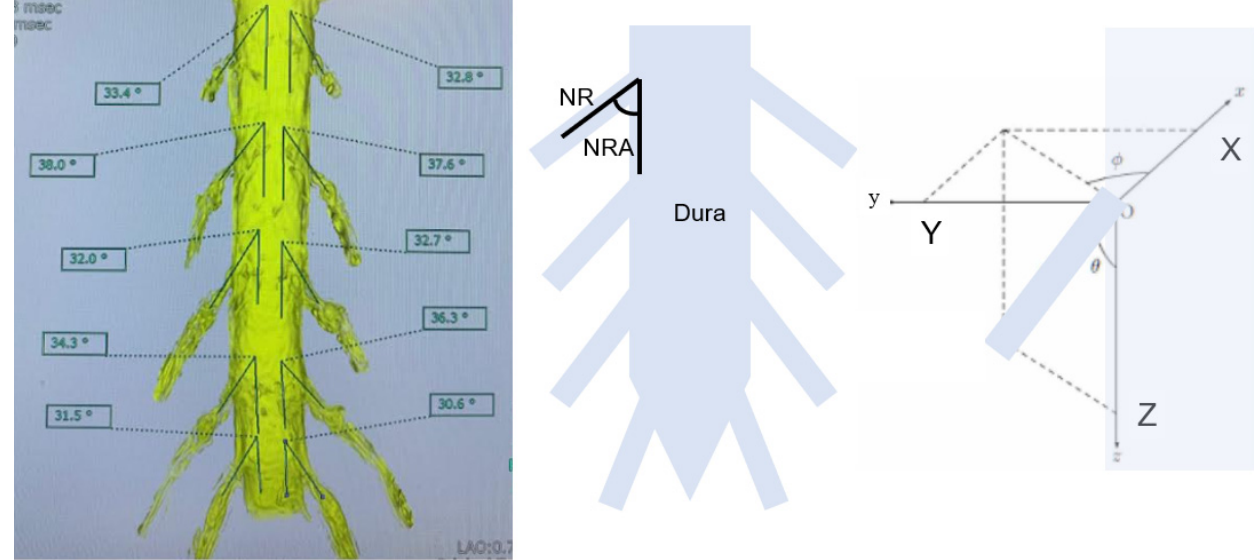
Figure 3. 3-D nerve root angle (3DNRA).